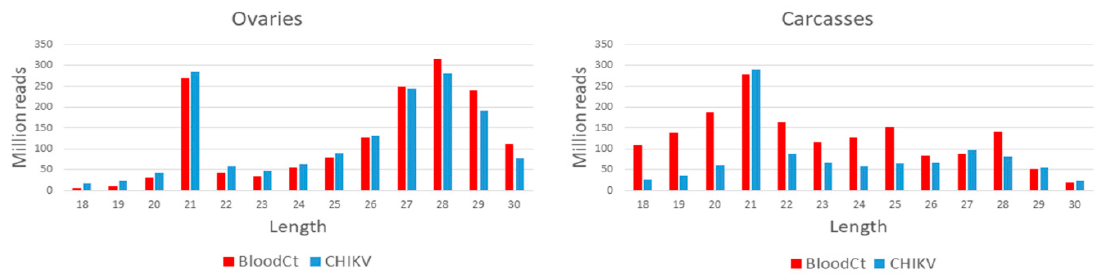
Figure 1. Size distribution of small RNAs reads mapping to the Aedes albopictus genome from ovary and carcass samples. Reads from chikungunya (CHIKV)-infected and uninfected samples are in blue and red, respectively.